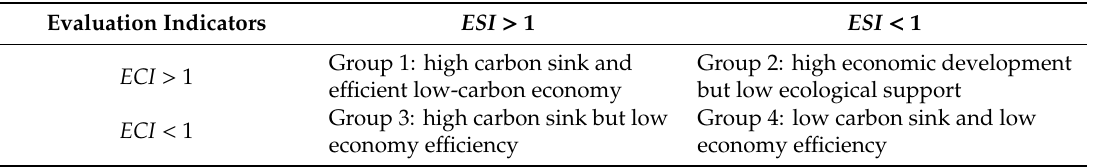
Table 1. Evaluation matrix of carbon